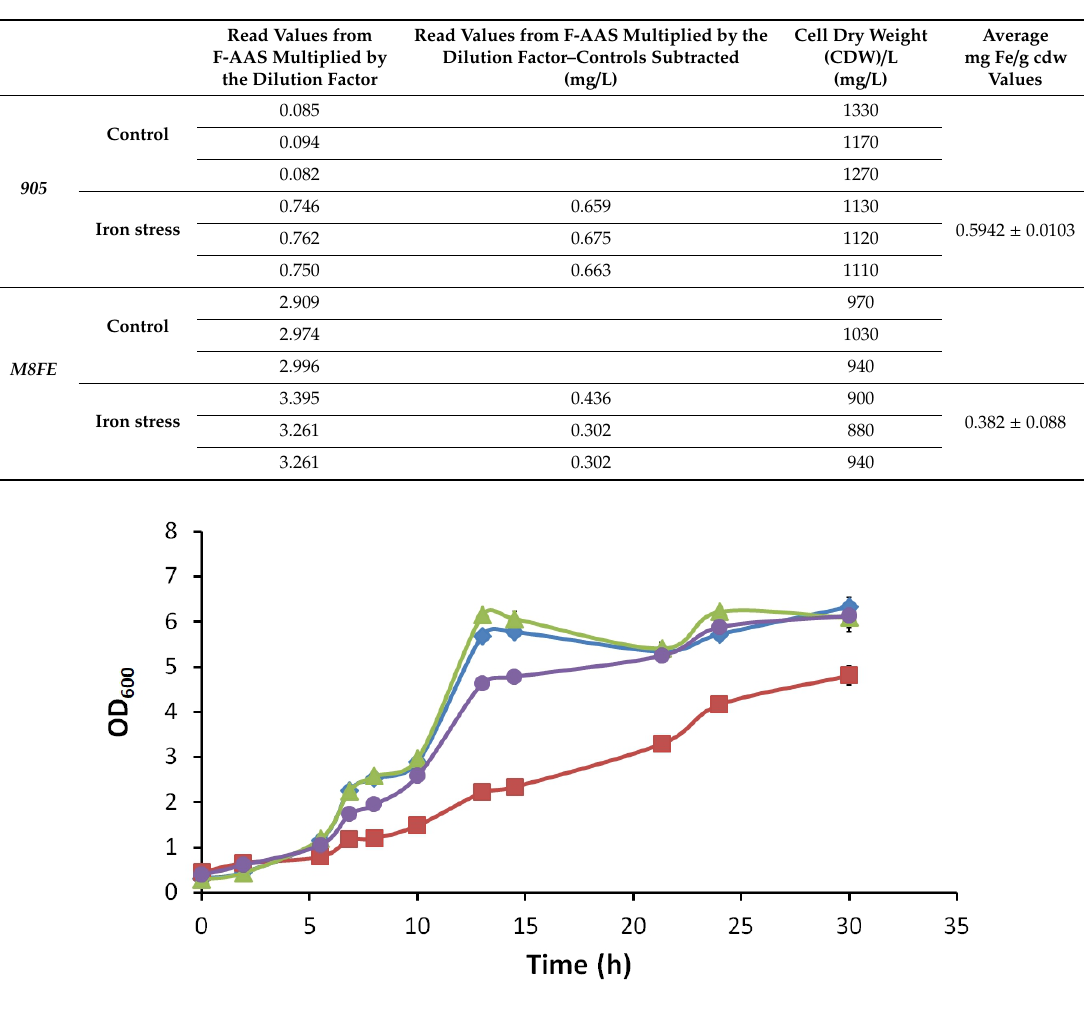
Figure 3. Growth profiles of 905 and M8FE in the absence and presence of 15 mM (NH 4 ) 2 Fe(SO 4 ) 2 stress. (cid:95) 905 under control condition, (cid:4) 905 under iron stress condition, (cid:78) M8FE under control condition, (cid:8) M8FE under iron stress